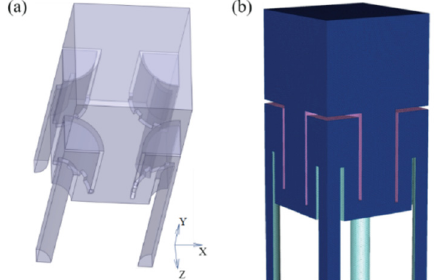
Fig. 6. (a) Distribution plate fl uid domain geometric model;